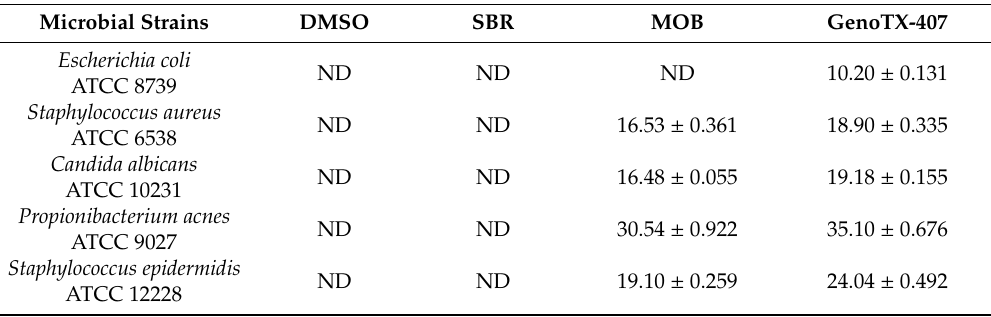
Table 2. Antimicrobial activities of extracts of Scutellaria baicalensis root (SBR), Magnolia o ffi cinalis bark (MOB), and the combination of SBR and MOB, i.e., GenoTX-407, determined using the agar disk di ff usion